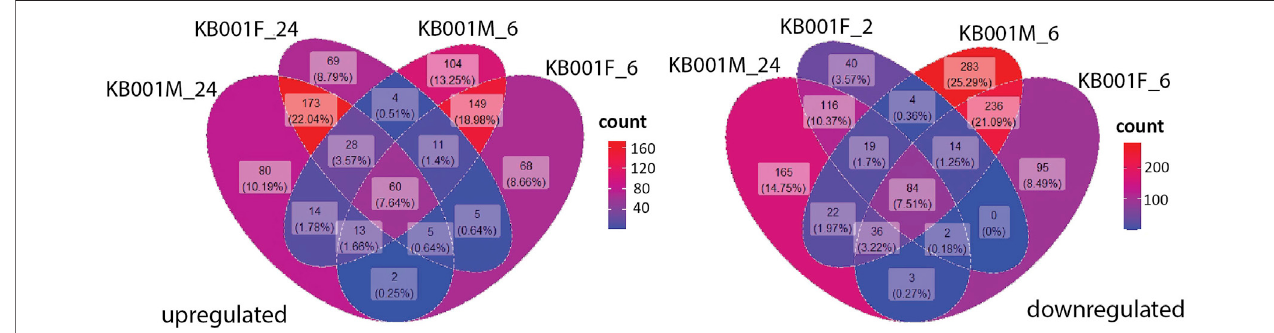
FIGURE 7 | Comparison of genes up- and downregulated in the KB001 treatment groups at different time points. Pools of Arabidopsis genes expressed after the KB001 treatment groups KB001_M (microbial culture) and KB001_F (culture fi ltrate) 6 h (KB001M_6 and KB001F_6) and 24 h posttreatment (KB001M_24 and KB001F_24). The number (count) of genes expressed in a certain group is given in a gradient color